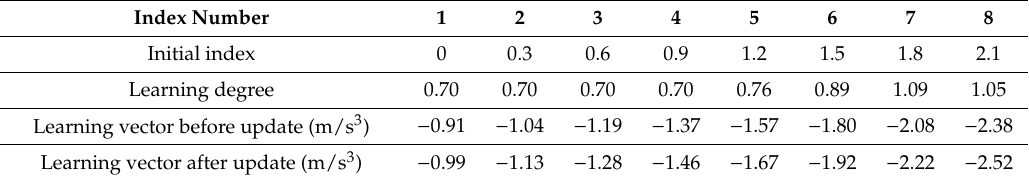
Table 7. Specifications of radar sensor. Index